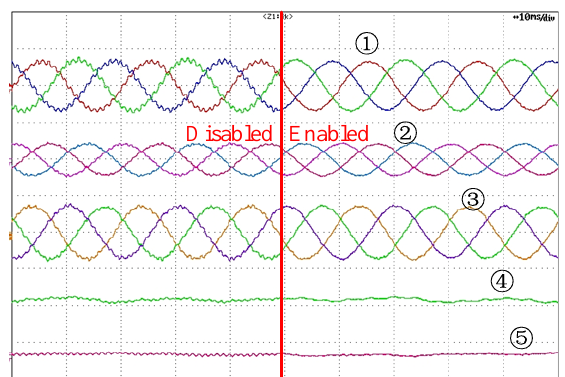
Figure 19. HFR damping for integral system ① V abc (100 V/div), ② I VSCI (8 A/div), ③ I VSCII (8 A/div), ④ P t (1.5 kW/div), ⑤ Q t (1.5 kVar/div).